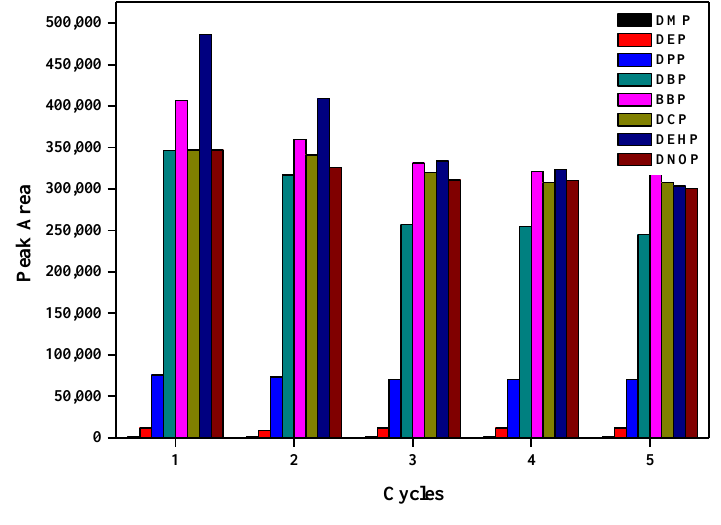
Figure 9. Reusability